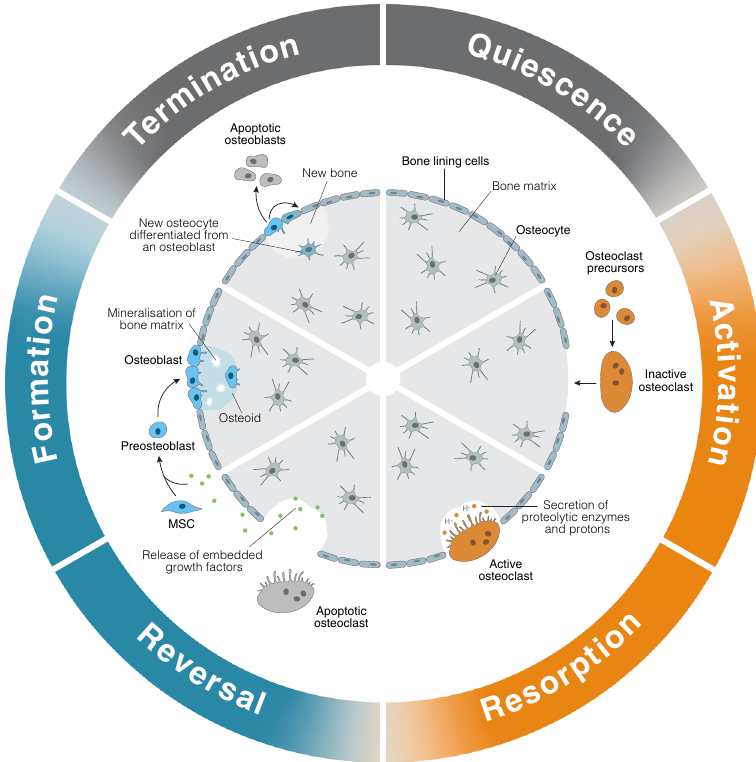
Fig. 1 The stages of bone remodelling. Bone remodelling is a process where cycles of bone resorption and formation are separated by periods of quiescence. During quiescence, the relatively inactive bone surface is lined by fl at remnants of osteoblasts. Events such as hormone detection and/or mechanical loading can activate the recruitment of circulating osteoclast precursor cells. These precursor cells fuse to form premature osteoclasts and migrate to the bone surface, while bone lining cells retract to enable preosteoclast binding. Once bound to the bone matrix to form a sealing zone in the isolated area, they differentiate into mature osteoclasts for bone resorption. Mature osteoclasts secrete protons to create an acidic environment that dissolves bone mineral, and proteolytic enzymes to digest the bone matrix. The resorption process results in the formation of cavities, also known as Howship ’ s lacunae, beneath active osteoclasts. Osteoclasts undergo apoptosis once these cavities reach a certain size, leading to the termination of bone resorption. The bone degradation process also releases embedded growth factors that reverses bone resorption by recruiting and stimulating the differentiation of mesenchymal stem cells (MSCs) into bone-forming osteoblast lineage cells. Once recruited to the lacunae, preosteoblasts secrete a variety of matrix proteins in the organic bone matrix, or the osteoid, which are then mineralised by mature osteoblasts. Bone formation is terminated upon completion of mineralisation. Osteoblasts either undergo apoptosis or differentiation into quiescent bone lining cells. Alternatively, osteoblasts can become embedded in the bone matrix to form osteocytes, which form a canalicular network of branched dendritic processes to communicate with bone lining cells, osteoblasts, and other